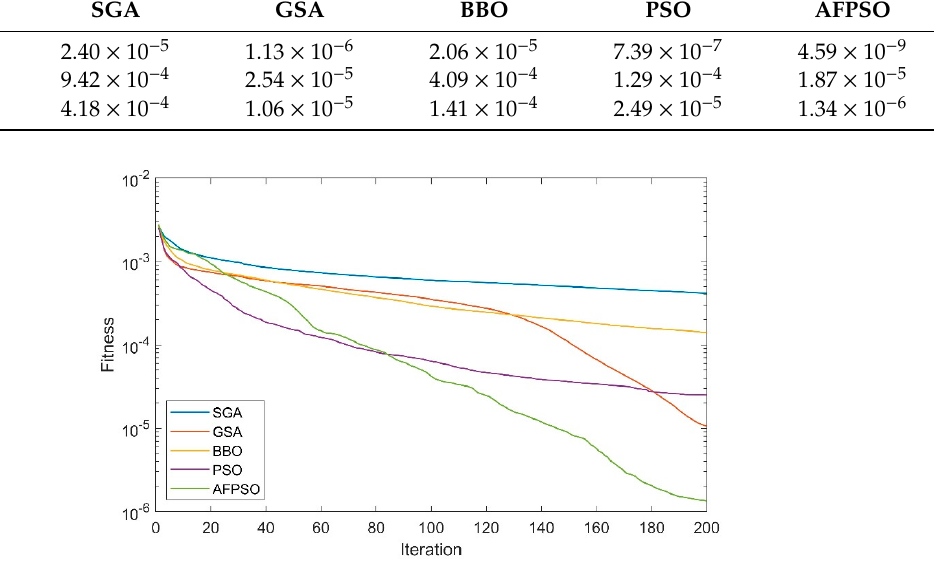
Figure 10. Average fitness change of the algorithms during parameter estimation (load condition).